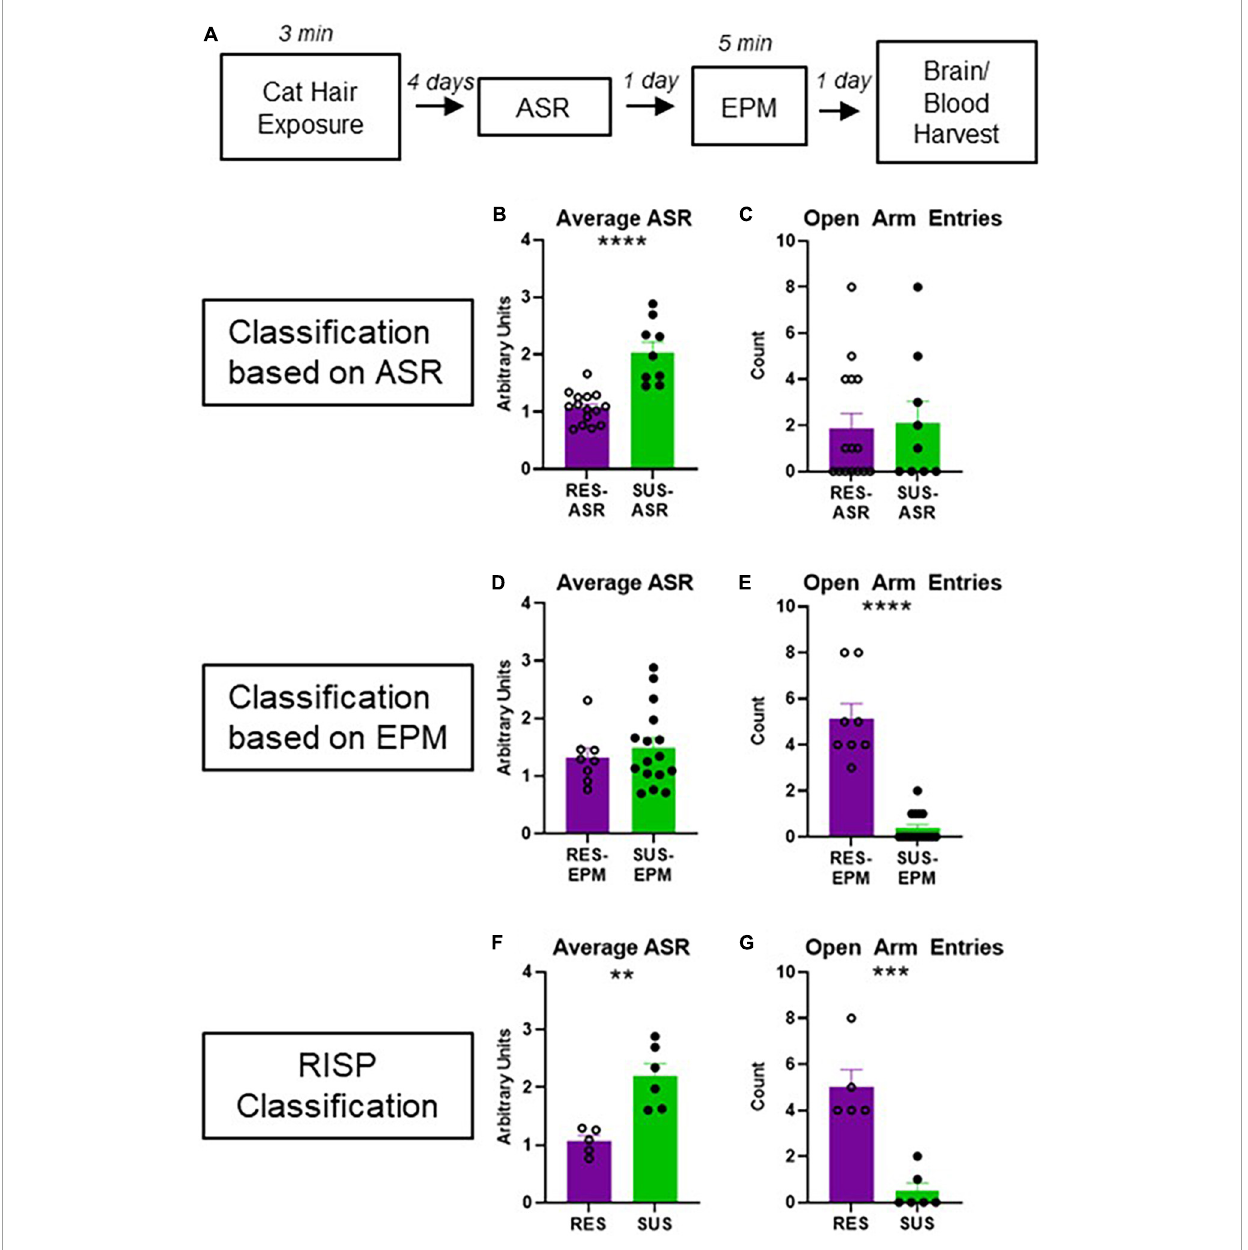
FIGURE1 Experimental design and behavioral classification. (A) Experimental design; (B) average ASR of rats classified as Res-ASR or Sus-ASR (Res n = 15, Sus n = 9); (C) number of EPM Open Arm Entries of rats classified as Res-ASR or Sus-ASR (Res n = 15, Sus n = 9); (D) average ASR of rats classified as Res-EPM or Sus-EPM (Res n = 8, Sus n = 16); (E) number of EPM Open Arm Entries of rats classified as Res-EPM or Sus-EPM (Res n = 8, Sus n = 16); (F) average ASR of rats classified as Res or Sus with the RISP model (Res n = 5, Sus n = 6); (G) number of EPM Open Arm Entries of rats classified as Res or Sus with the RISP model (Res n = 5, Sus n = 6). ** p < 0.01, *** p < 0.001, and **** p <